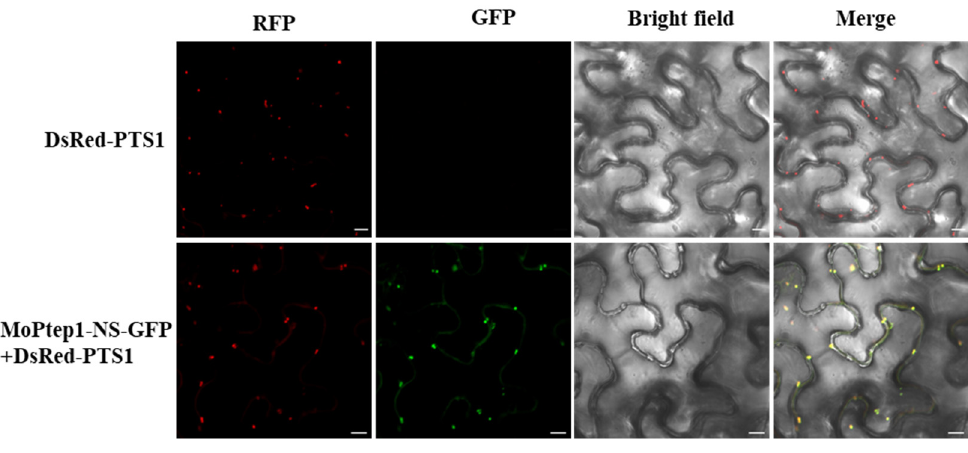
Figure 6. Subcellular localization of MoPtep1 in the peroxisomes in N. benthamiana leaf cells. Confocal images were taken from N. benthamiana leaf cells infiltrated by EHA105 containing the corresponding constructs at 36–48 h post inoculation (hpi). DsRed-PTS1 fusion construct was the peroxisome marker. Scale bars = 10 μ m.